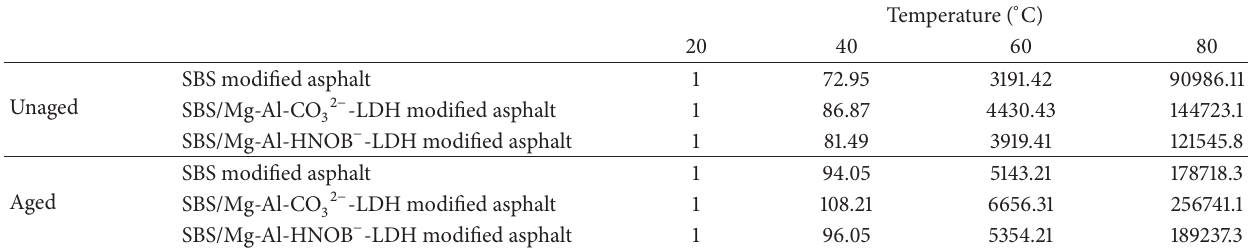
Figure 12: Master curve of (a) aged SBS modified asphalt, (b) aged Zn/Al-CO 32− -LDH modified asphalt, and (c) aged Zn/Al-HNOB − -LDH modified asphalt. Table 4: Shift factors of asphalts in frequency